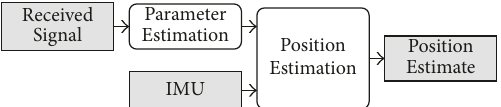
Figure 2: Based on the received signal, the parameters of the propa- gation paths are estimated in the first step by the KEST algorithm. In the second step, the estimates serve as measurements for estimating the positions of the user and the physical and virtual transmitters. In addition, user heading rates of change measurements from an IMU are incorporated in the second